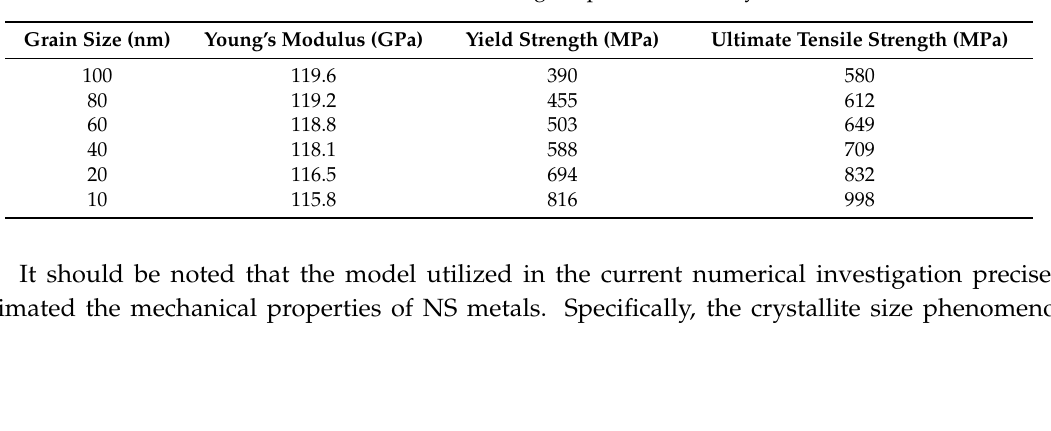
Figure 16. The numerical outcomes of nanocrystalline NC copper for the investigation of the elastoplastic behavior by varying the grain size from 100 nm to 10 nm. Table 2. Numerical findings of parametric